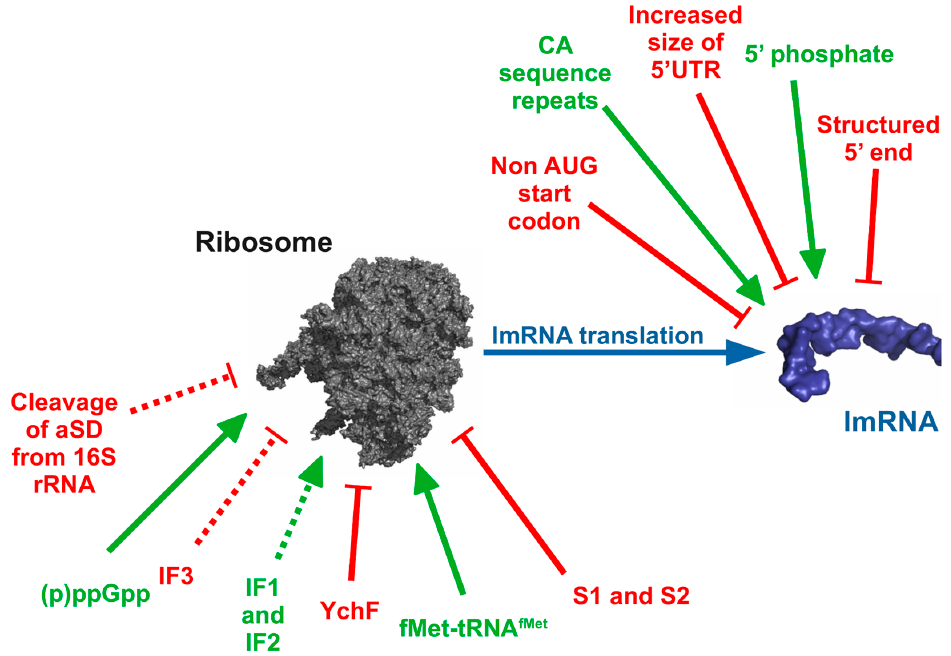
Figure 2. Control of lmRNA translation. It has been observed that several factors or leaderless mRNA (lmRNA) properties may alter lmRNA translation efficiency. Shown at the top are lmRNA properties that enhance (green) or repress (red) lmRNA translation, and at the bottom are other factors that alter lmRNA translation, probably through interaction with ribosome. Dotted lines indicate factors where changing conditions or strains produce discordant results. Please refer to main text for full details regarding each case. Models of ribosomal and RNA structures were constructed using PYMOL molecular graphics system [32] and pdb 4V9M [33].